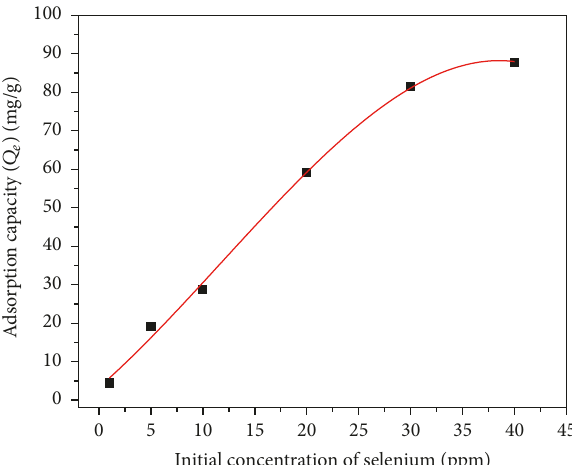
Figure 9: Effect of CNTs-20% iron oxide dosage on selenium removal (agitation speed = 150 rpm, pH = 6, time = 6 hr, and initial concentration =